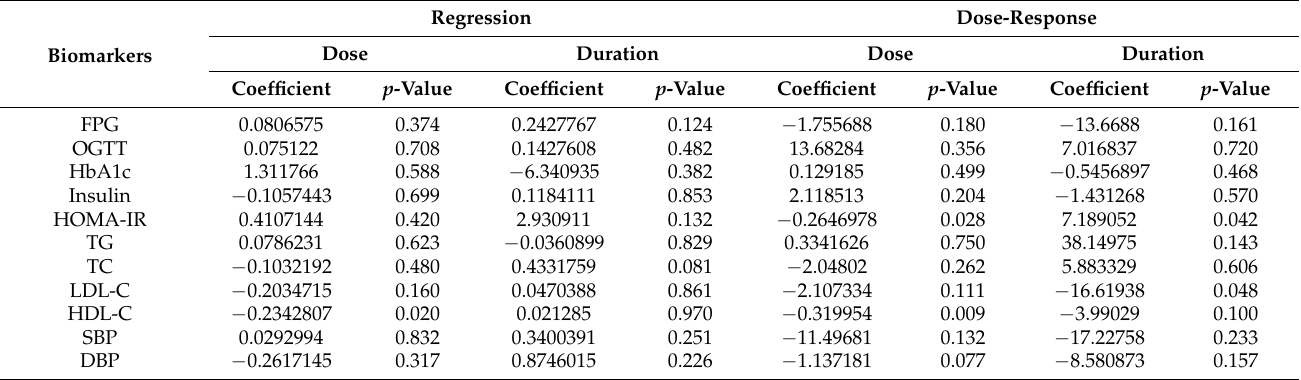
Table 4. Linear and non-linear dose-responses between dose and duration of Panax supplementation and cardiometabolic